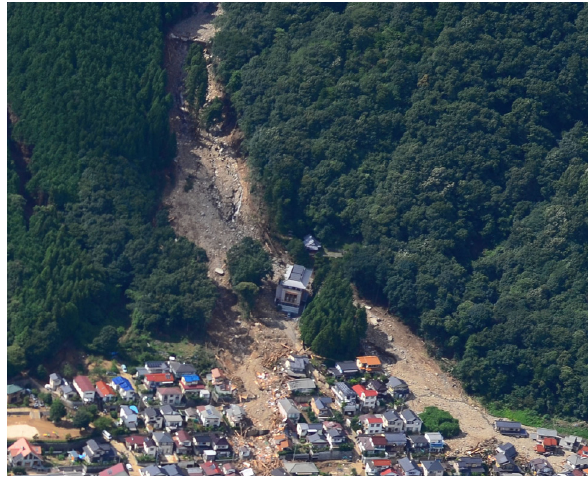
Figure 15. Asaminami Ward Yagi district (2).